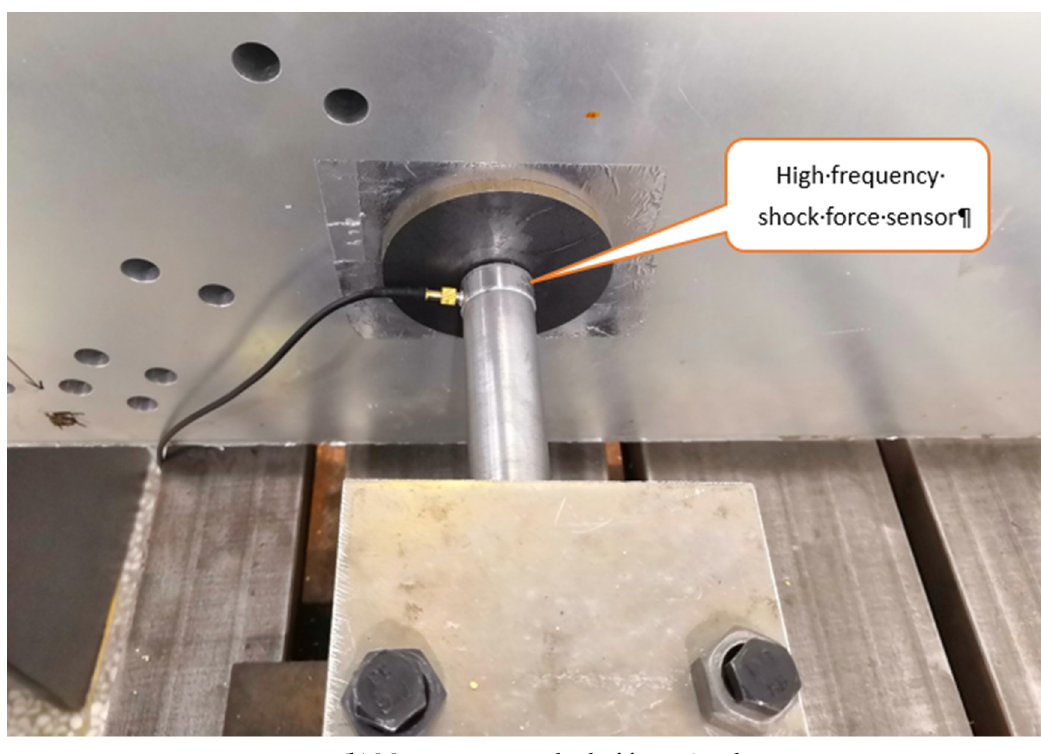
Figure 4. Shock loading device and measurement method of force signal.